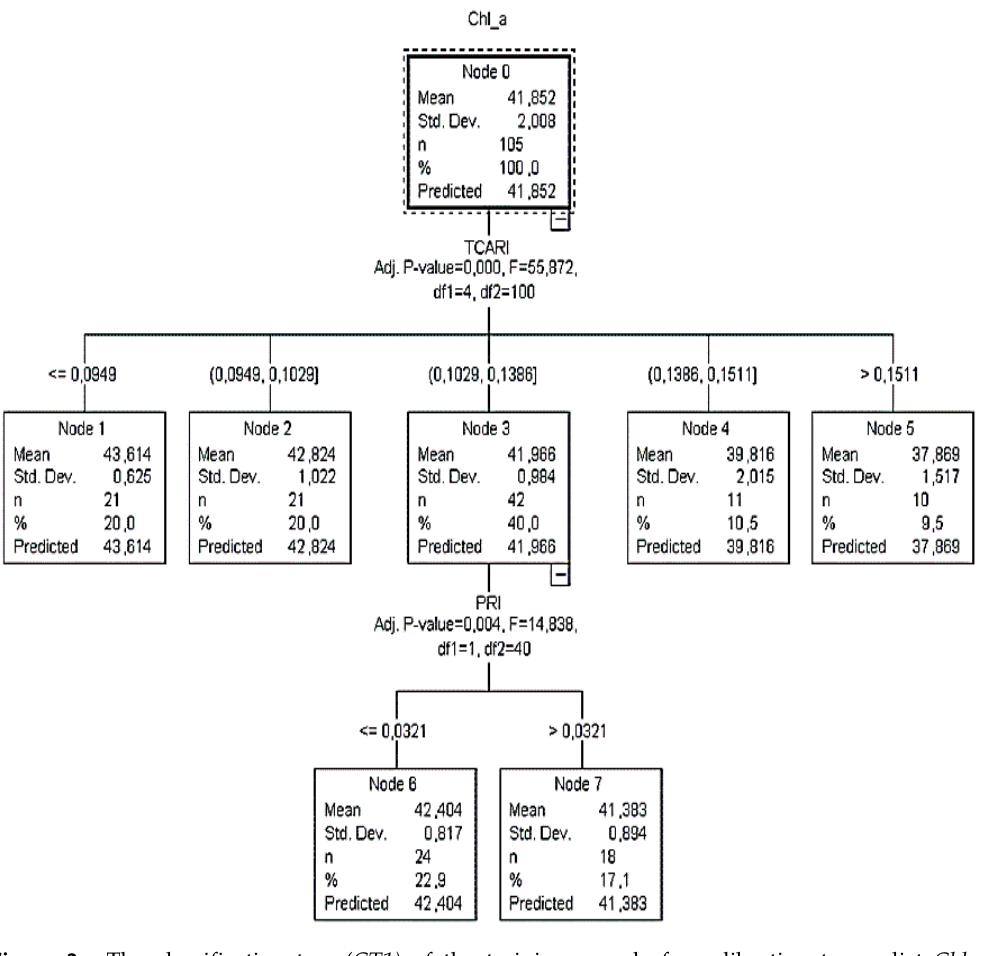
Figure 2. The classification tree ( CT1) of the training sample for calibration to predict Chl_a concentration in the leaf area (μg cm − 2 ).